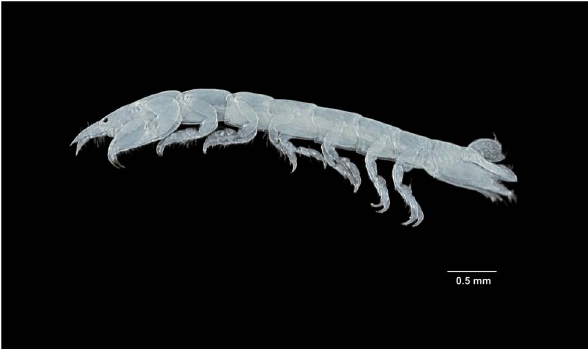
Figure 3. Tinggianthuraalba sp. n. All scales represent 0.5 mm. (A) holotype female lateral (UKMMZ-1479), (B) holotype female dorsal (UKMMZ-1479), (C) allotype male dorsal (UKMMZ-1480).